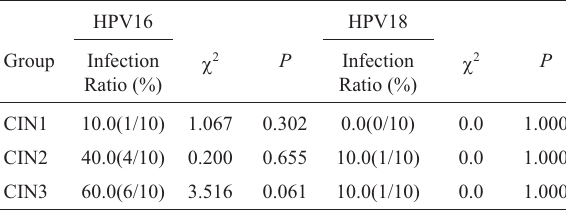
Table 2 - Infection status of HPV16/18 in CIN